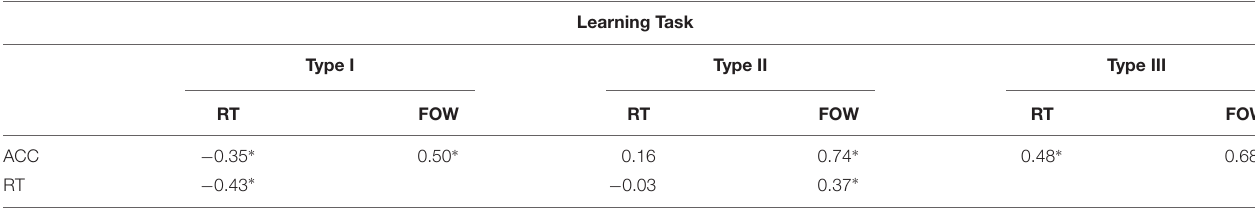
TABLE 2 | Correlations between performance measures observed in Experiment 2.